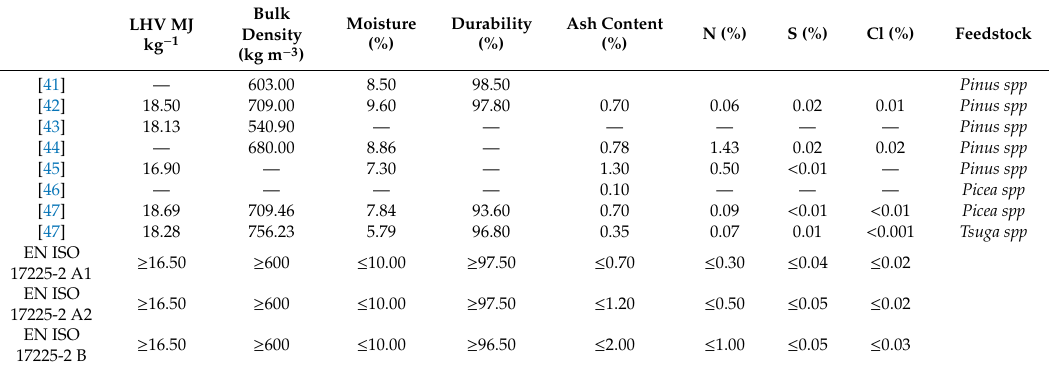
Table 1. Characteristics of pellet produced from pine, hemlock and spruce and ISO 17225-2 standards requirements for A1, A2, and B